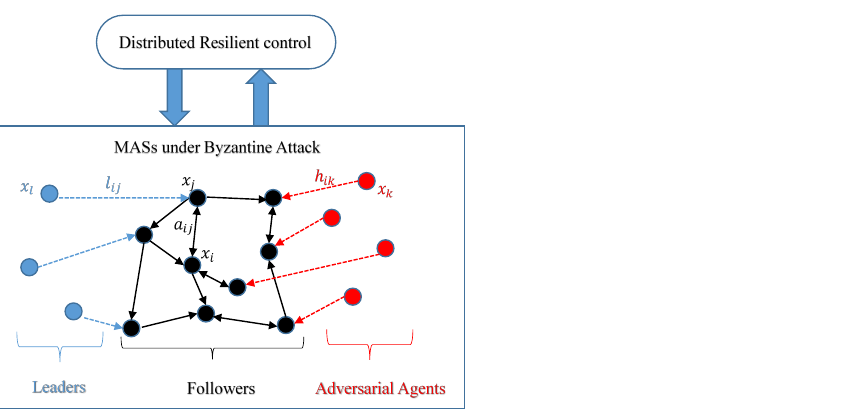
Figure 5. The diagram of a Byzantine attack. When the communication topology of agent i meets certain conditions, each follower x i can not only directly receive the data of neighbor agent x j ( a ij (cid:54) = 0), but also directly receive data from leaders x l ( l ij (cid:54) = 0) and adversarial agents x k ( h ik (cid:54) = 0). It is worth noting that the abnormal state information sent by x k may lead the system to an unexpected direction or even cause the system to